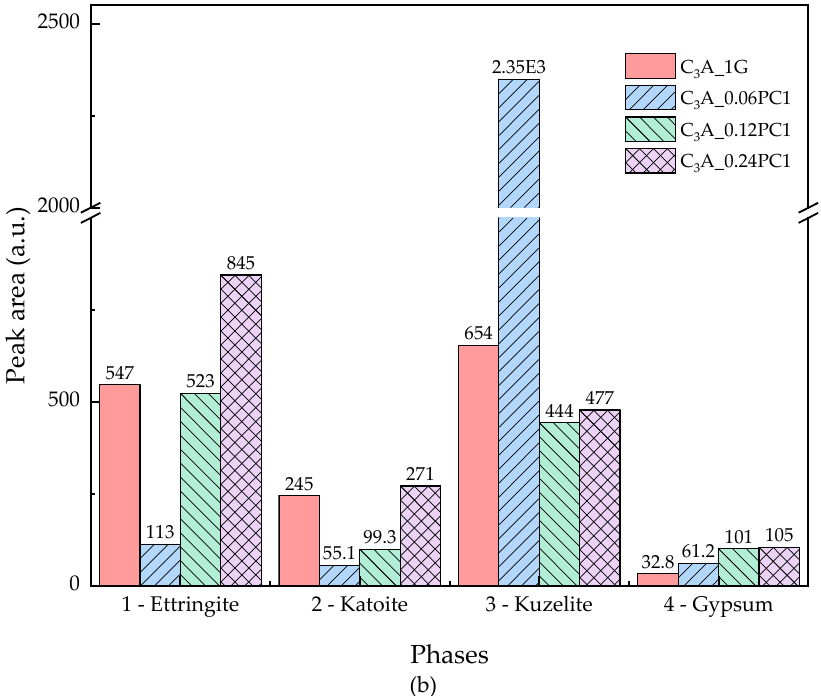
Figure 5. ( a ) XRD patterns of phases obtained from C 3 A-gypsum with different concentrations of PC1 solution after the 24-h hydration. ( b ) XRD peak area of each phase in (a).